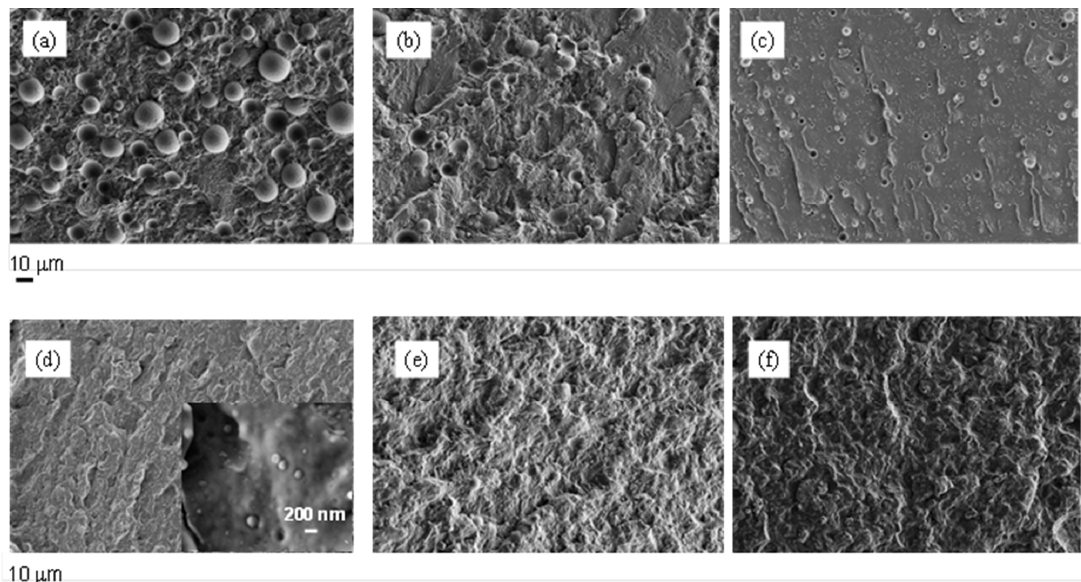
Figure 1. FE-SEM micrographs of: ( a ) PLLA70/PGA30, ( b ) PLLA80/PGA20, ( c ) PLLA90/PGA10, ( d ) PCL70/PGA30, ( e ) PCL80/PGA20, ( f ) PCL90/PGA10.